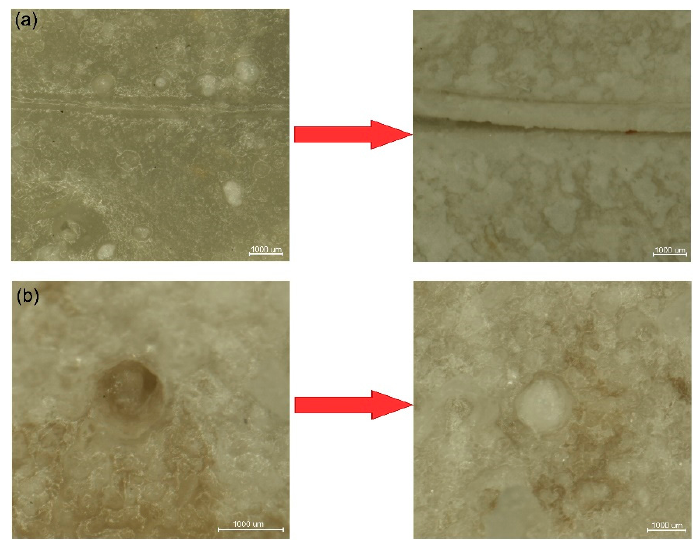
Figure 4. Optical microscopic images before and after healing: ( a ) crack (width 0.7–1 mm) and ( b ) cavity ( Φ = 1 mm).